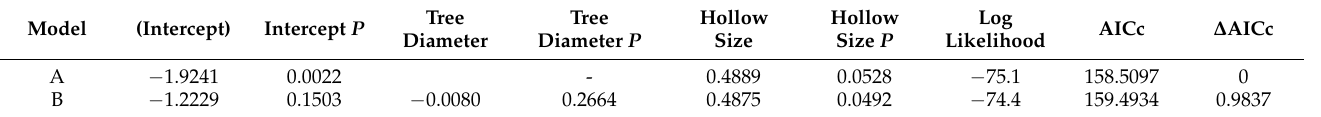
Table 4. Coefficients and p -values of the two best GLMM models shown with log likelihood, AICc, and difference in AICc ( ∆ AICc). The model containing only hollow size as a fixed effect was selected based on the principle of parsimony. Model A represents the best model, containing only the hollow size and random effects. Model B contains the hollow size and tree diameter as fixed effects as well as random effects. Model B has a ∆ AICc lower than 2, and therefore is considered equivalent to the best model. Model A, containing only the hollow size as a fixed effect, was selected as the best model based on the principle of parsimony.